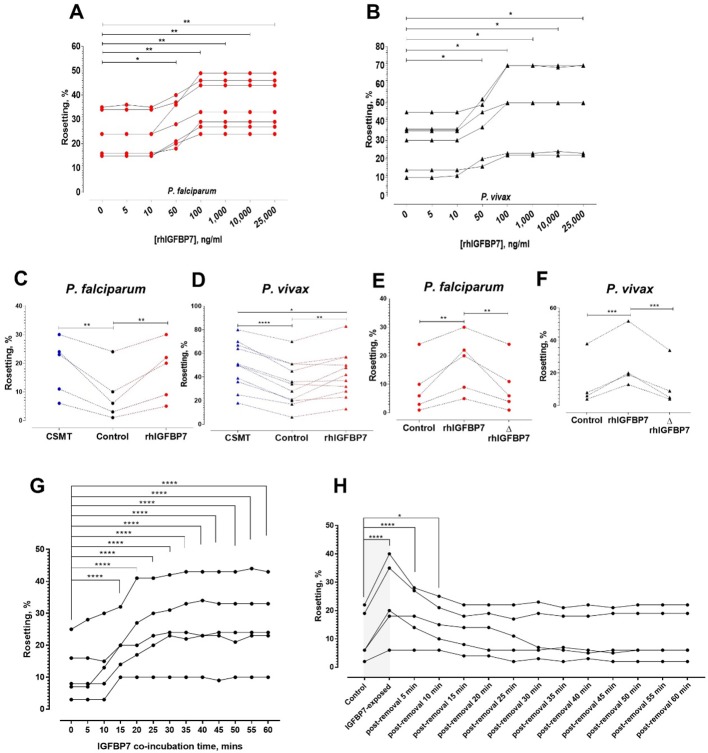
Characterization of IGFBP7-mediated rosetting.(A, B) Rosetting rates post-rhIGFBP7-incubation. Significant rosette-stimulation was noted at 50 ng/ml rhIGFBP7 (one-way ANOVA with Dunnett’s test: Pf (n = 7): p=0.0224; Pv (n = 7): p=0.0419) and a plateau was reached after 100 ng/ml (Pf: p=0.0045; Pv: p=0.0168). (C, D) Comparison of rosette-stimulatory effects between the CSMT and rhIGFBP7 in P. falciparum (n = 5) (one-way ANOVA with Tukey’s test: control vs. CMST: p=0.0019; control vs. rhIGFBP7: p=0.0054; CMST vs. rhIGFBP7: p=0.6866) (C) and P. vivax (n = 11) (one-way ANOVA with Tukey’s test: control vs. CMST: p<0.0001; control vs. rhIGFBP7: p=0.0039; CMST vs. rhIGFBP7: p=0.0108) (D). (E, F) Impact of heat denaturation on rosette-stimulatory effect of rhIGFBP7 in P. falciparum (n = 5) (E) (one-way ANOVA with Tukey’s test: control vs. rhIGFBP7: p=0.0036; control vs. ΔrhIGFBP7: p=0.9721; rhIGFBP7 vs. ΔrhIGFBP7: p=0.0048) and P. vivax (n = 4) (F) (one-way ANOVA with Tukey’s test: control vs. rhIGFBP7: p=0.0006; Control vs. ΔrhIGFBP7: p=0.8008; rhIGFBP7 vs. ΔrhIGFBP7: p=0.0004). (G) Changes in lab-adapted Pf (n = 5) rosetting rates after incubation with IGFBP7 up till the 60th minute (one-way ANOVA with Dunnett’s test: significant increment was detected as fast as the 15th minute (and onwards): p=0.0001). (H) Changes in rosetting rates of lab-adapted Pf (n = 5) after IGFBP7-exposure (covered by the gray box), followed by removal of IGFBP7 from the system in the span of 60 min (one-way ANOVA with Dunnett’s test: significant rosetting rate increment was seen after IGFBP7 exposure: p=0.0001). The rosetting rates were still significantly higher than the baseline (control) 5 min (p=0.0001) and 10 min (p=0.0265) after IGFBP7-removal. From the 15th to the 60th minute post-IGFBP7 removal, the rosetting rates dropped to levels that were of no significant difference with the baseline values.